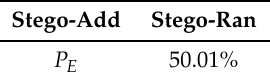
Table 7. The comparison of undetectability possibility results between embedding contents.